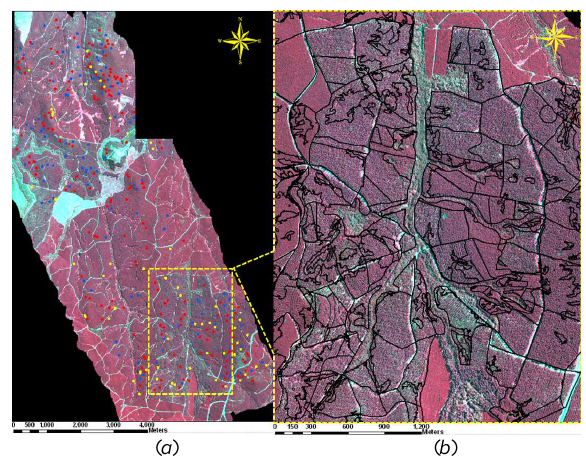
Figure 1. ( a )Study area and the field data (yellow circles) as well as sample plots, training data (red circles) and test data (blue circles) shown on WV-2 false colour image (7, 5 and 3 as red, green and blue); ( b ) the aerial photogrammetric interpretation (API)